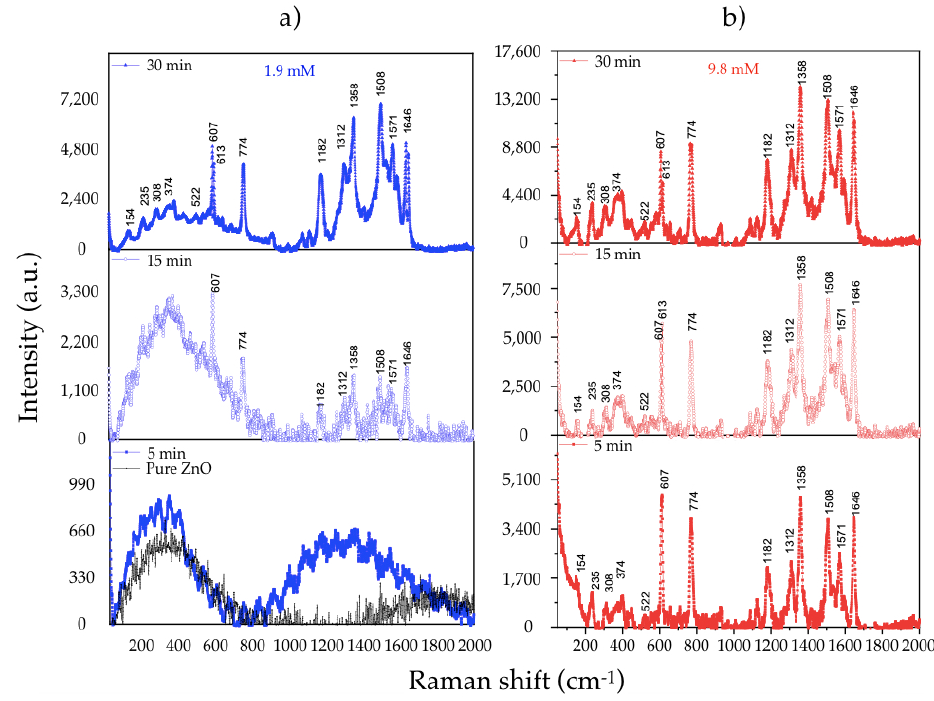
Figure 10. Raman spectra of R6G for ( a ) pure ZnO and using 1.9 and ( b ) 9.8 mM of AgNO 3 during 5, 15, and 30 min.